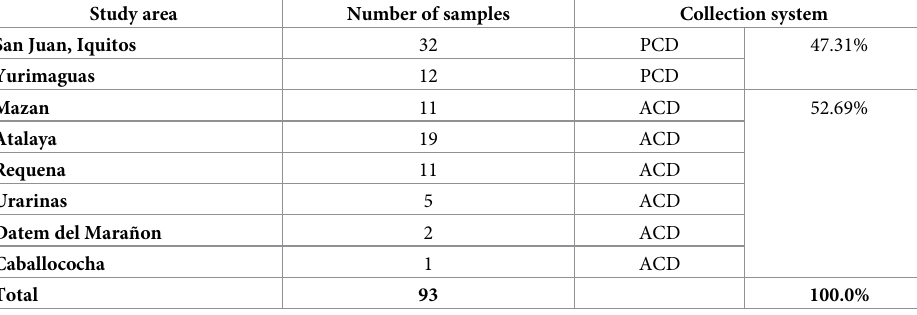
Table 1. Origin of P . falciparum samples collected in Peruvian amazon